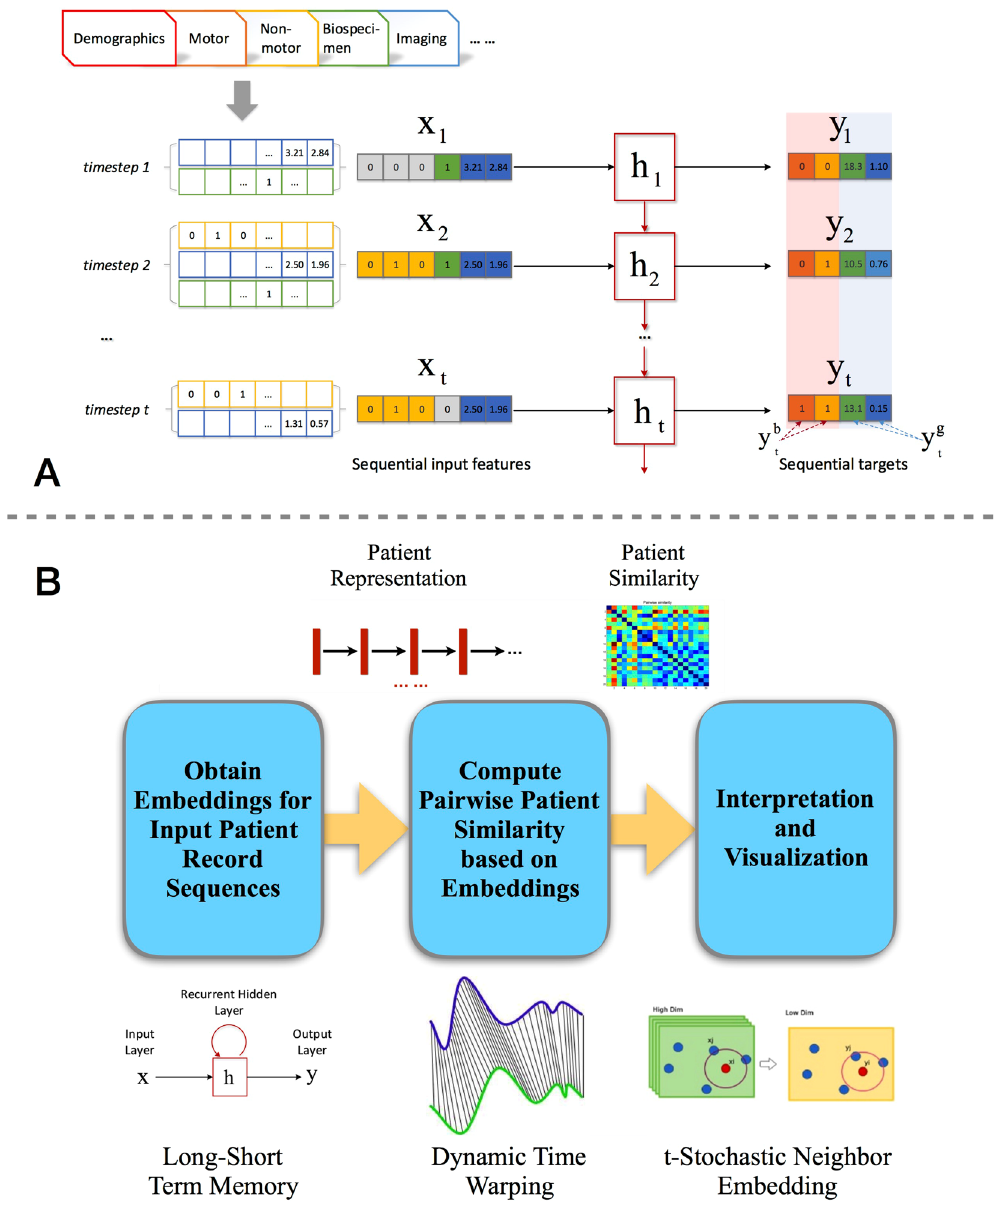
Figure 1. The proposed data-driven subtyping method. ( A ) Illustration of our LSTM recurrent neural network. The patient representation derived by recurrent hidden layer. Raw patient multi-source data are pre- processed by imputation. For each patient, the merged temporal records are set as input of LSTM corresponding each timestamp. The targets are a set of disjoint temporal records for each patient and obtained by the same pre-process method. There are two kinds of targets function for continuous and binary values separately. Representations generated by all the hidden states are used in patient subtyping. ( B ) Overall flow of the proposed LSTM-based